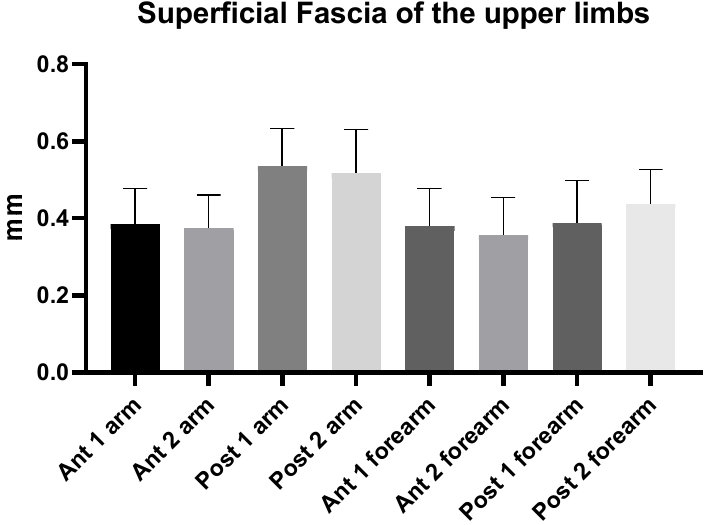
Figure 5. Ultrasound thickness measurements of the superficial fascia of the arm and forearm at different regions/levels.